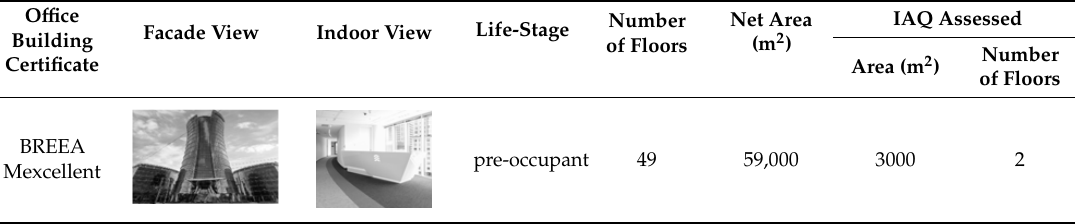
Table 4. Information on the building in the case study.